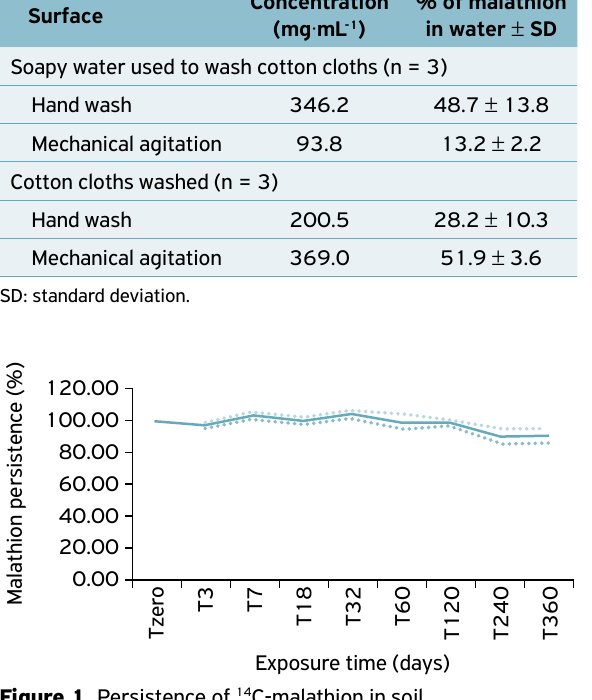
Figure 1. Persistence of 14 C-malathion in